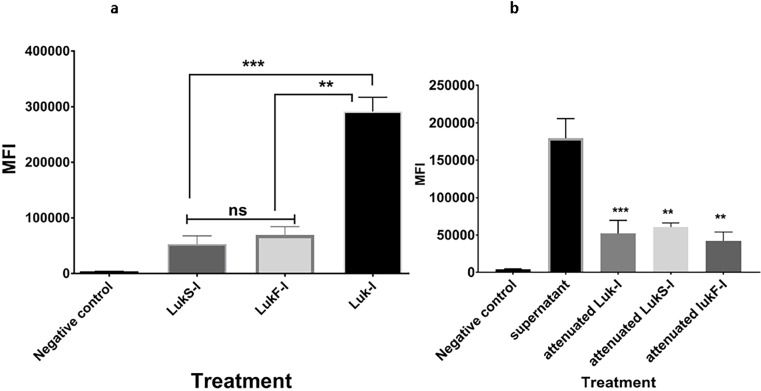
Cytotoxic effect of S. pseudintermedius recombinant Luk-I on canine PMNs.PMN permeability assay using Sytox Green to detect the cytotoxic effect of wild-type Luk-I on canine PMNs. (A) Luk-I significantly induced PMN killing after 30 min compared to that with wild-type LukS-I (P = 0.0330***) and LukF-I (P = 0.0468**). (B) A1:2 S. pseudintermedius 06–3228 supernatant dilution significantly induced PMN killing after 30 min compared to that with and attenuated LukS-I (P = 0.0276**), attenuated LukF-I (P = 0.0268**) and attenuated Luk-I treatments (P = 0.0044***). The mean fluorescent intensity (MFI) of all treatment were calculated based on average values from three independent experiments. (*P < 0.05 was considered significant). ns–Not significant.